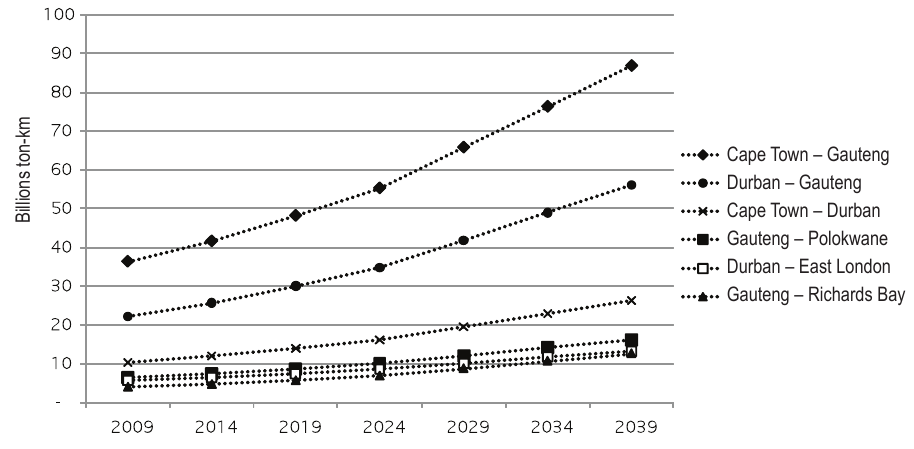
Figure 3: Corridor growth in the top six corridors (bidirectional, road-rail traffic) (data source: FDM, 2009)